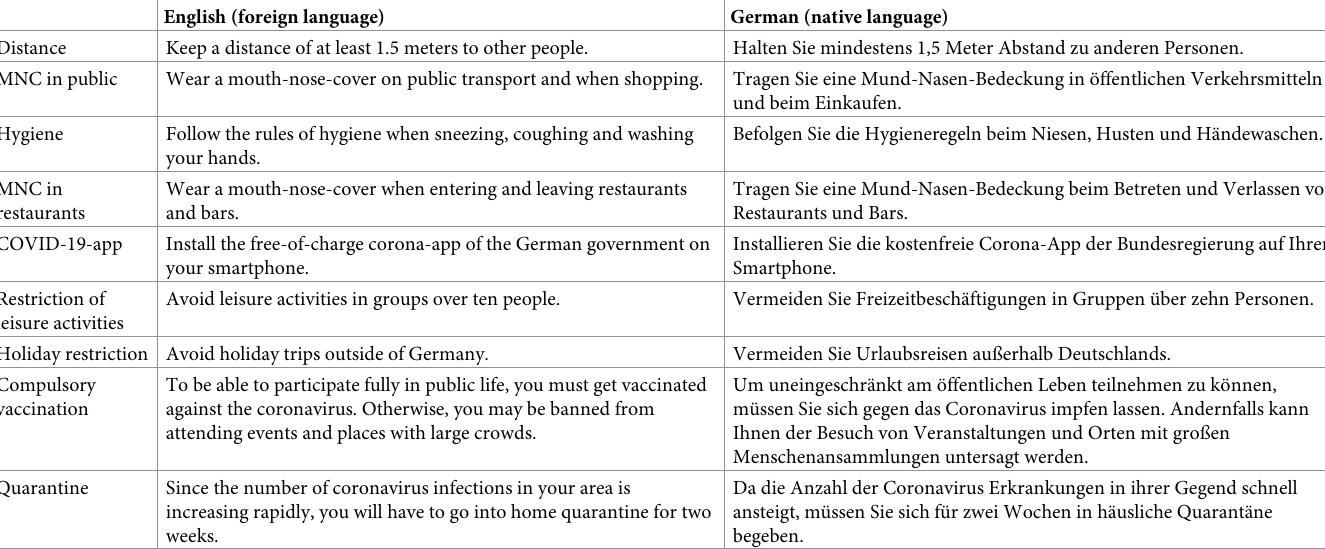
Table 1. COVID-19 mitigation instructions used as